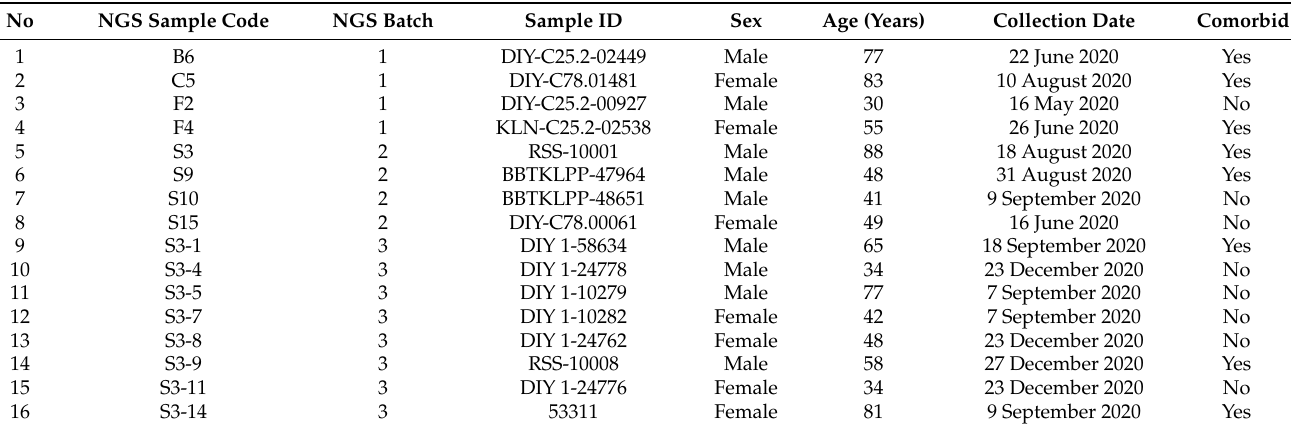
Table 1. Data of patients with COVID-19 from Yogyakarta and Central Java that were involved in this